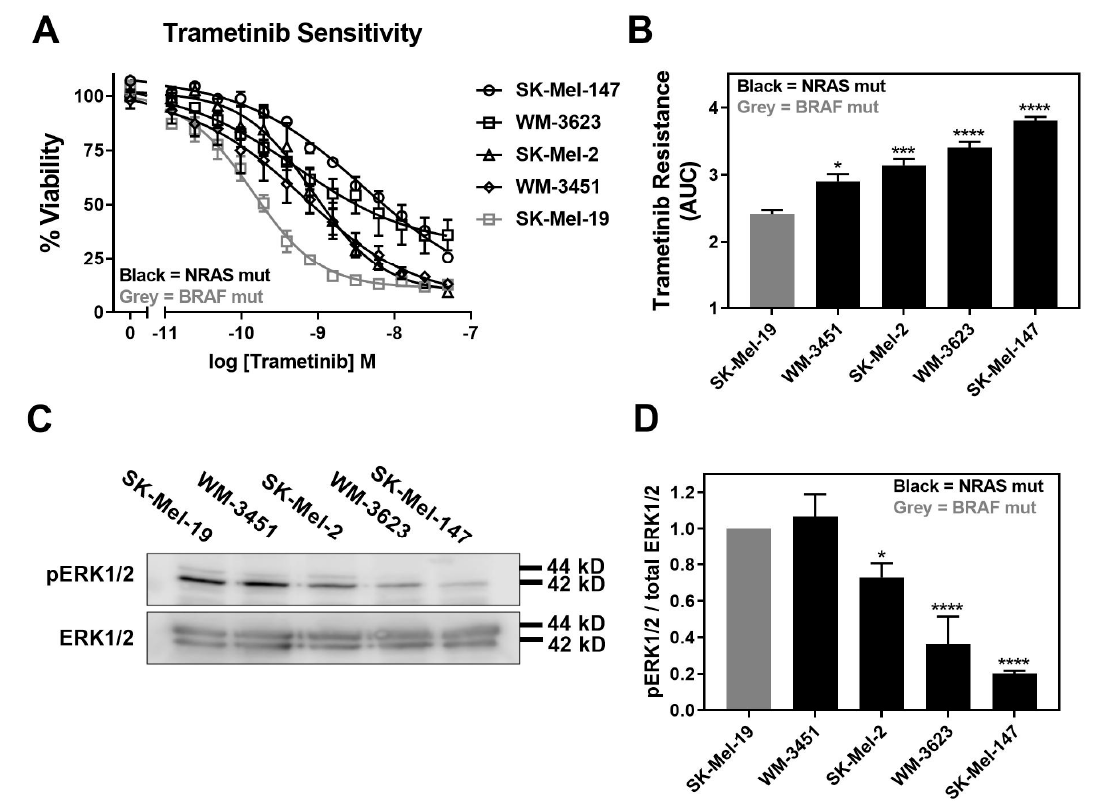
Figure 1. Increased trametinib resistance correlates with decreased pERK1/2. ( A ). Sensitivity to trametinib was determined by treating each cell line in 10% FBS with increasing concentrations of trametinib for 72 h. Cell viability was determined using Cell-TiterGLO ® . Values are expressed as the fraction of luminescence over vehicle control for three independent experiments. ( B ). The area under the curve was plotted based on the concentration response curves generated in panel A using GraphPad Prism (n = 3, * p < 0.05, *** p < 0.01, **** p < 0.001 vs. SK-Mel-19). A greater area means less response to trametinib or increased trametinib resistance. ( C ). Western blot analysis of pERK1/2 across the cell line panel (n = 3). Each melanoma cell line was plated in 60 mm dishes in 10% FBS and harvested 24 h later. Image is a representative blot from three separate experiments. ( D ). Quantitative band density analysis was performed for each experiment comparing the intensity of pERK1/2 relative to total ERK. Results are expressed as the mean (±SEM) of triplicate experiments (n = 3, * p < 0.05, **** p < 0.001 vs. SK-Mel-19).